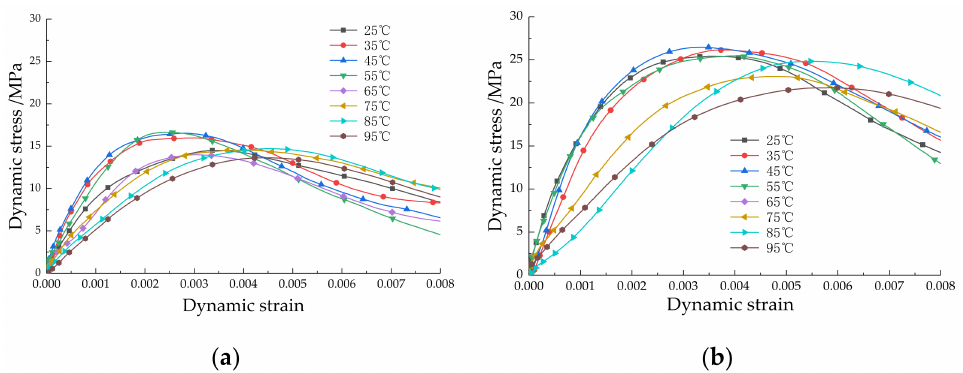
Figure 8. Stress–strain curves: ( a ) stress–strain curves of annular sandstone specimens; ( b ) stress– strain curves of intact sandstone